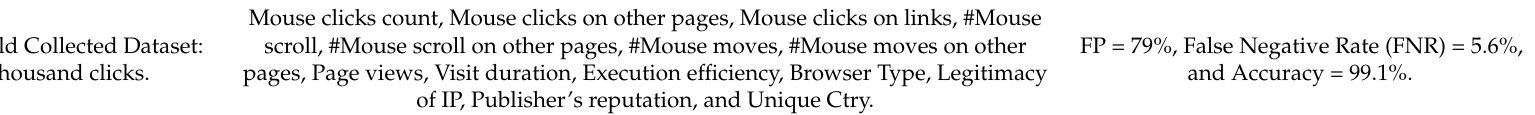
Mouse clicks count, Mouse clicks on other pages, Mouse clicks on links, #Mouse scroll, #Mouse scroll on other pages, #Mouse moves, #Mouse moves on other pages, Page views, Visit duration, Execution efficiency, Browser Type,